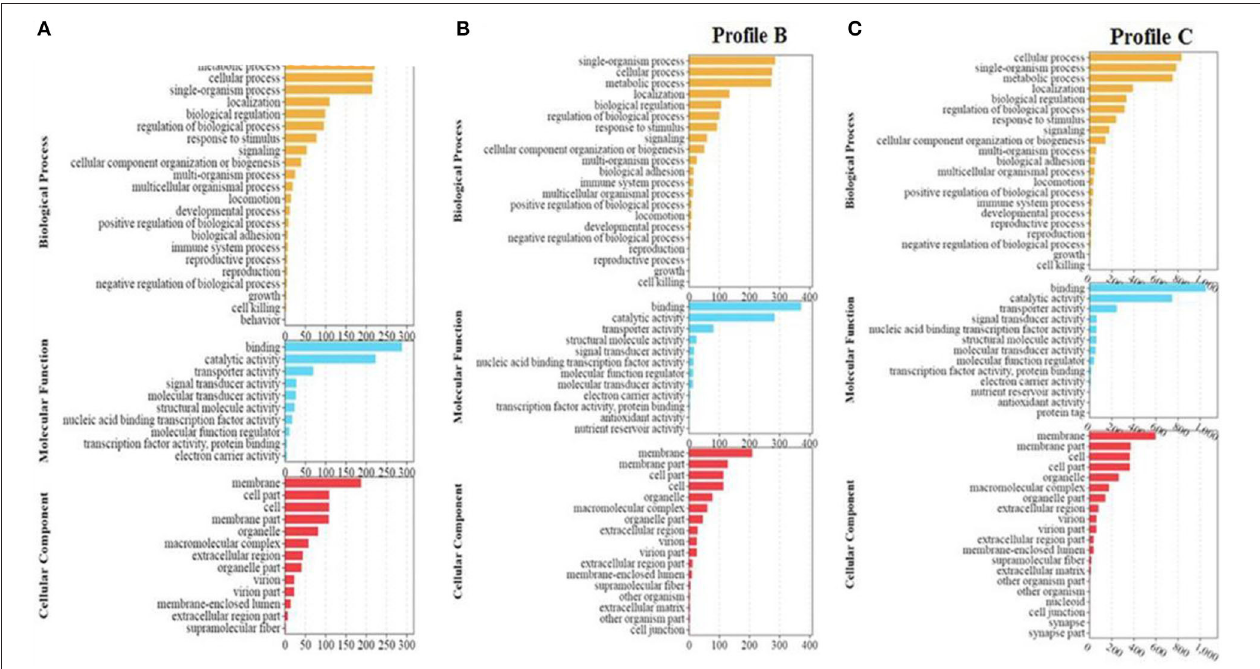
FIGURE 4 | (A–C) GO enrichment analysis of significant differential genes between soybean meal and fermented soybean meal in hindgut of pearl gentian grouper ( n =